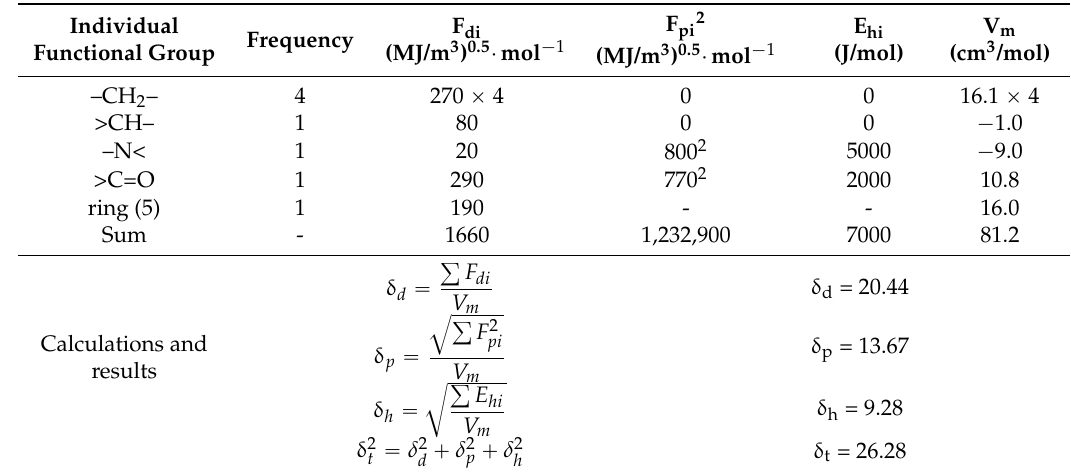
Table 8. Calculation of solubility parameters for the polymer polyvinylpyrrolidone, using the group contribution method of Hoftyzer and Van